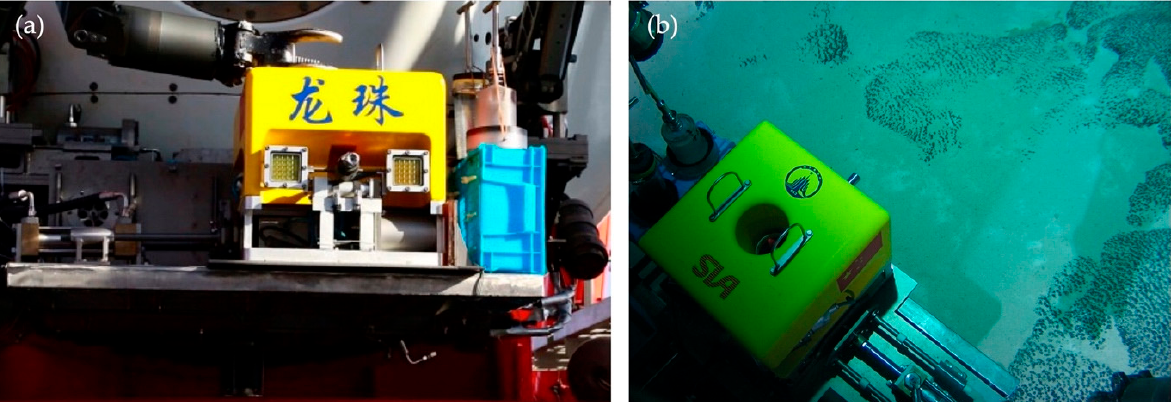
Figure 1. Cooperative operation of Jiaolong HOV and Longzhu ARV. ( a ) Longzhu ARV is placed on the sampling basket of the Jiaolong HOV before diving. ( b ) Longzhu ARV dived to the seabed with Jiaolong HOV. The Chinese characters on ARV is Longzhu, which is the name of ARV.